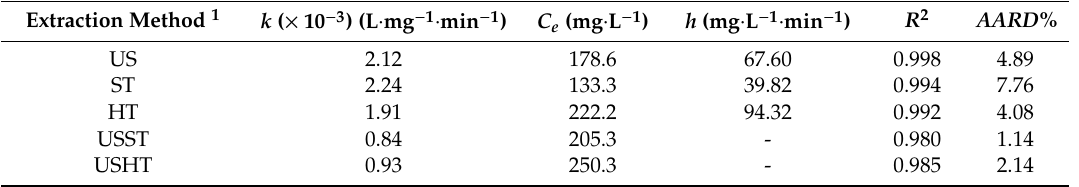
Table 1. Kinetic parameters obtained for the di ff erent extraction